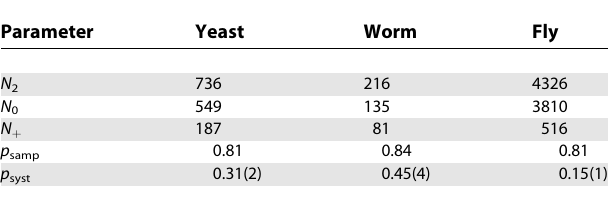
Table 8. Parameter Estimates for the True-Positive Rates for Avoiding Systematic Losses